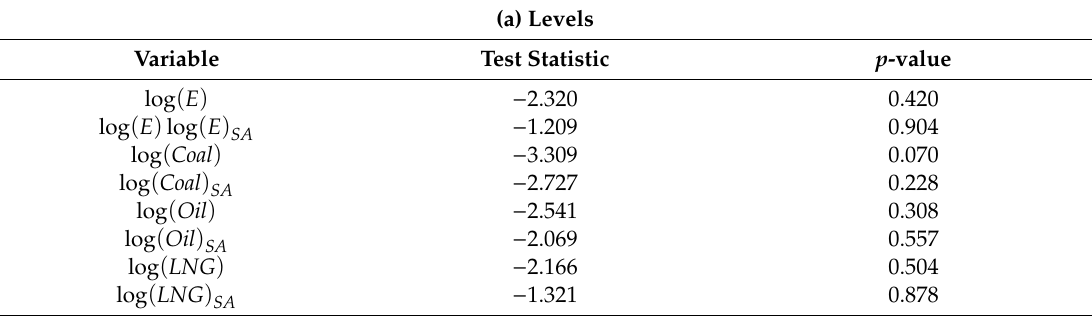
Table 2. Phillips-Perron unit root